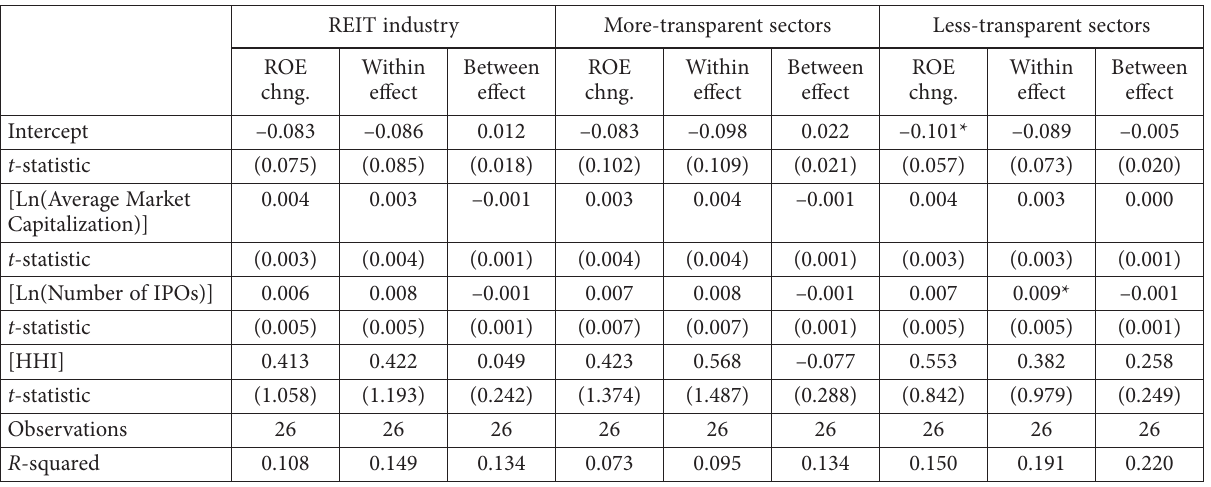
Table 5. OLS results on the annual changes in ROE, the “within” effect and the “between” effect REIT